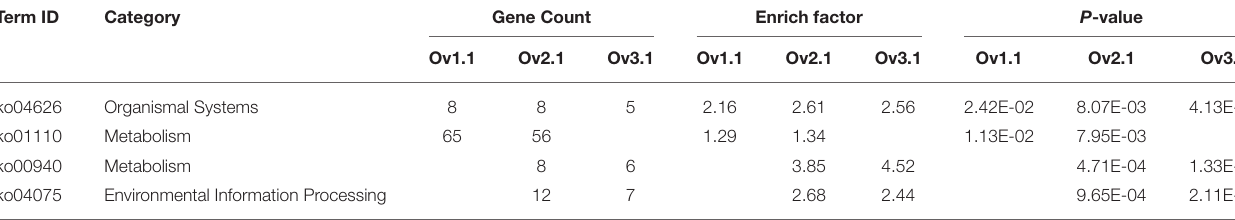
TABLE 3 | Overlapping significant enriched KEGG pathways at three ovule development stages in